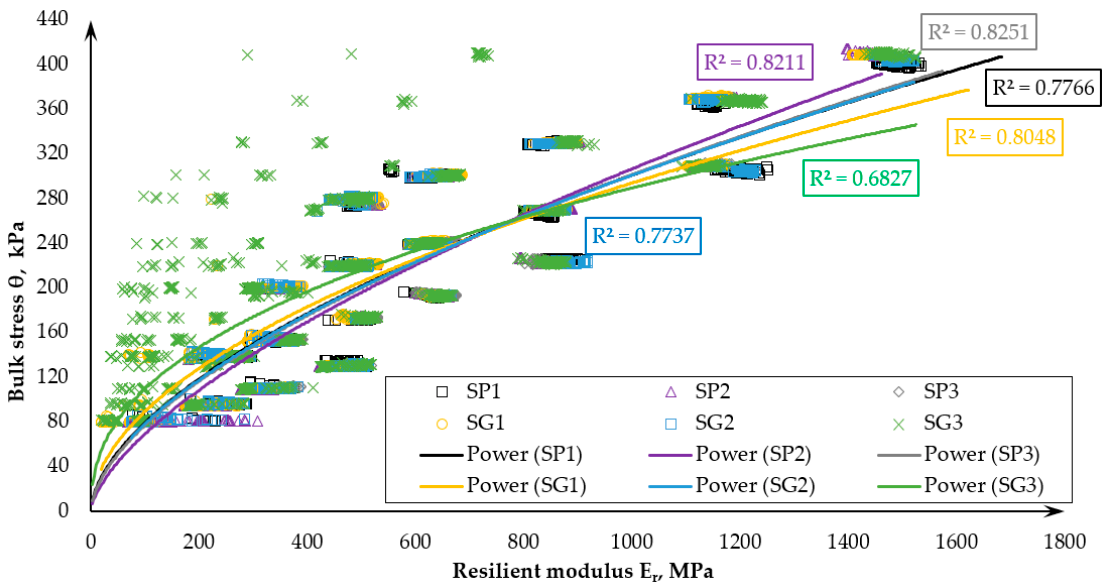
Figure 6. Resilient modulus correlation with bulk stress.